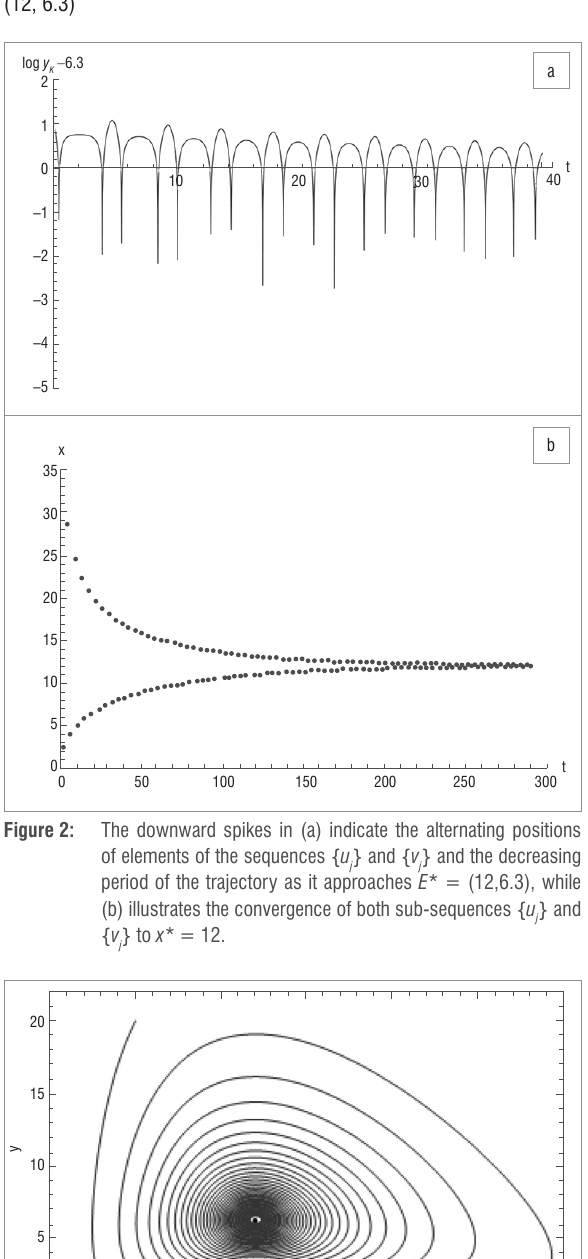
Sequence generated by the intersection of y = 6.6 and a trajectory of System 1B initiated at (5, 20), using a step size of 0.01